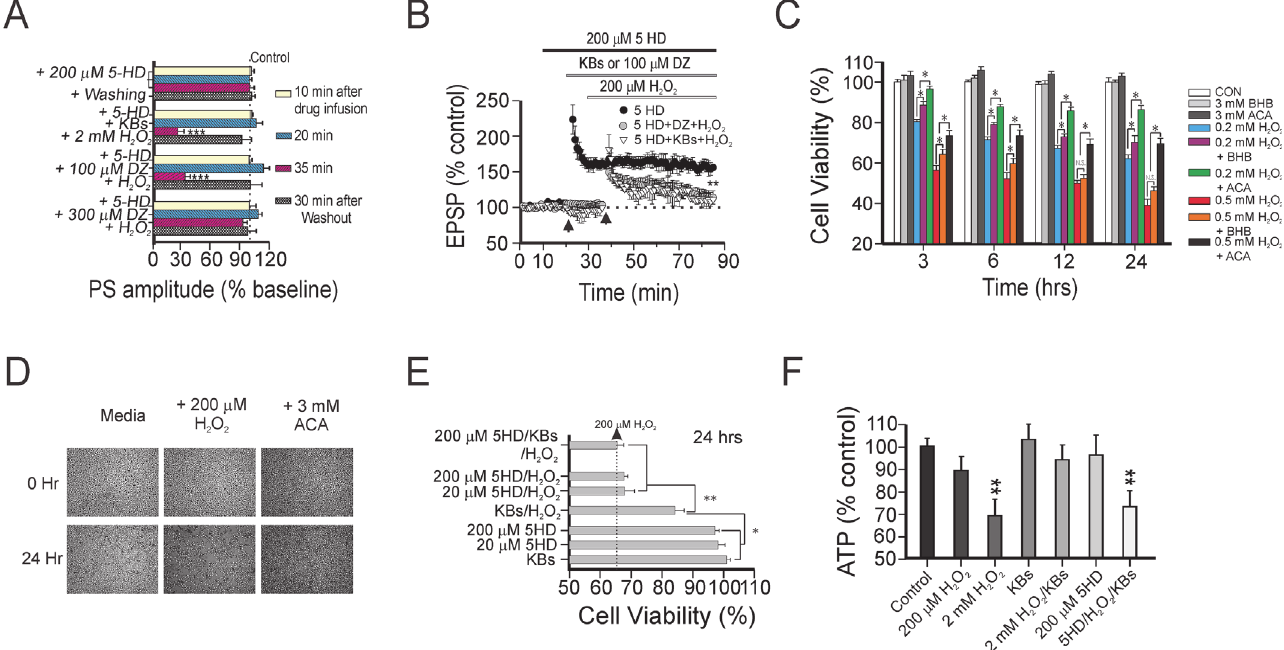
Fig 3. Pharmacological blockade of K ATP channels negates the hippocampal synaptic and neuronal protection afforded by ketones. (A) Changes in PS amplitude (as % of baseline) during or after drug application under different experimental conditions. No changes were seen in the PS amplitude during infusion with 200 μ M 5HD alone or 5HD with 300 μ M DZ and H 2 O 2 . There was a reversible, dose-dependent blockade by 5HD of the PS when either ketones or 100 μ M DZ were applied concurrently with H 2 O 2 . Asterisks denote significant differences between experimental groups and the control at a specific time- point ( *** p < 0.001). The dotted line indicates the mean PS amplitude of the control group. Each horizontal bar indicates mean PS amplitude ± SEM obtained in 12 slices from 5 rats. (B) Normal TBS-induced LTP was seen with 200 μ M 5HD. However, LTP was impaired when either ketones or 100 μ M DZ were administered together with 5-HD; the EPSP amplitude was measured 110 ± 9% and 115 ± 11% at 50 min post-TBS, respectively. Asterisks denote significant differences between 200 μ M 5-HD alone and other treatment groups ( ** , p < 0.01). Each LTP dataset was collected in 10 hippocampal slices. (C) Time-course of the MTT assay for cell viability in murine hippocampal HT22 cells treated with H 2 O 2 — with or without application of BHB or ACA (each 3 mM) — for 3, 6, 12, and 24 hours. Each vertical bar indicates the mean ± SEM (n = 30). (D) Representative photomicrographs of HT22 cells under control conditions, with H 2 O 2 , or when H 2 O 2 was co-treated with ACA at two time-points (0 and 24 hrs). (E) Oxidative-induced cell death in HT22 cells measured under different treatment conditions. While 20 μ M and 200 μ M 5HD alone had no influence on cell viability, ketone (each 1 mM)-mediated neuronal protection against oxidative injury was completely negated by 200 μ M 5HD. (F) Bar graphs illustrating changes in ATP levels in hippocampal CA1 samples treated with ketones with or without 5-HD on H 2 O 2 -induced oxidative stress after 2 hrs. ATP levels represented as % of control are mean ± SEM of 12 slices analyzed after 2 hr with indicated significant decreases ( ** p < 0.01) compared with control group, which was infused with physiological saline under similar experimental